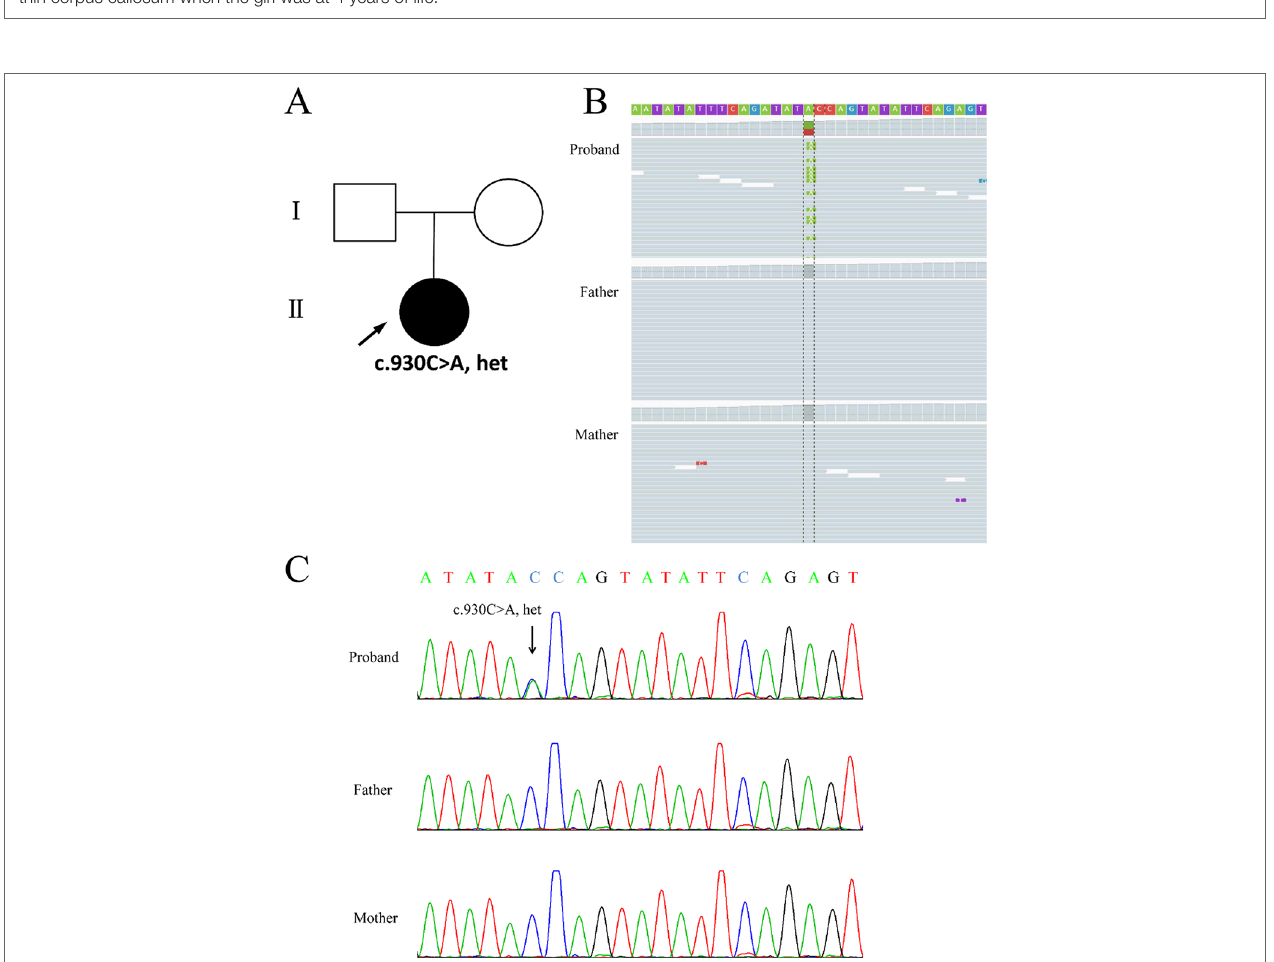
FIGURe 2 | Genetic findings from the family. (A) Pedigree of the family with segregation of the identified DYRK1A mutation. The square represents male, and circles represent female. Filled symbol indicates the affected individual. (B) Visualization of mutation in the DYRK1A gene is shown on the Integrative Genomics Viewer. Variation c.930C > A was heterozygous in the proband. (C) The variation of c.930C > A is a nonsense mutation (p.Tyr310*) identified in the proband. The parents were tested and did not carry the mutation. Black arrows indicate the point mutation.